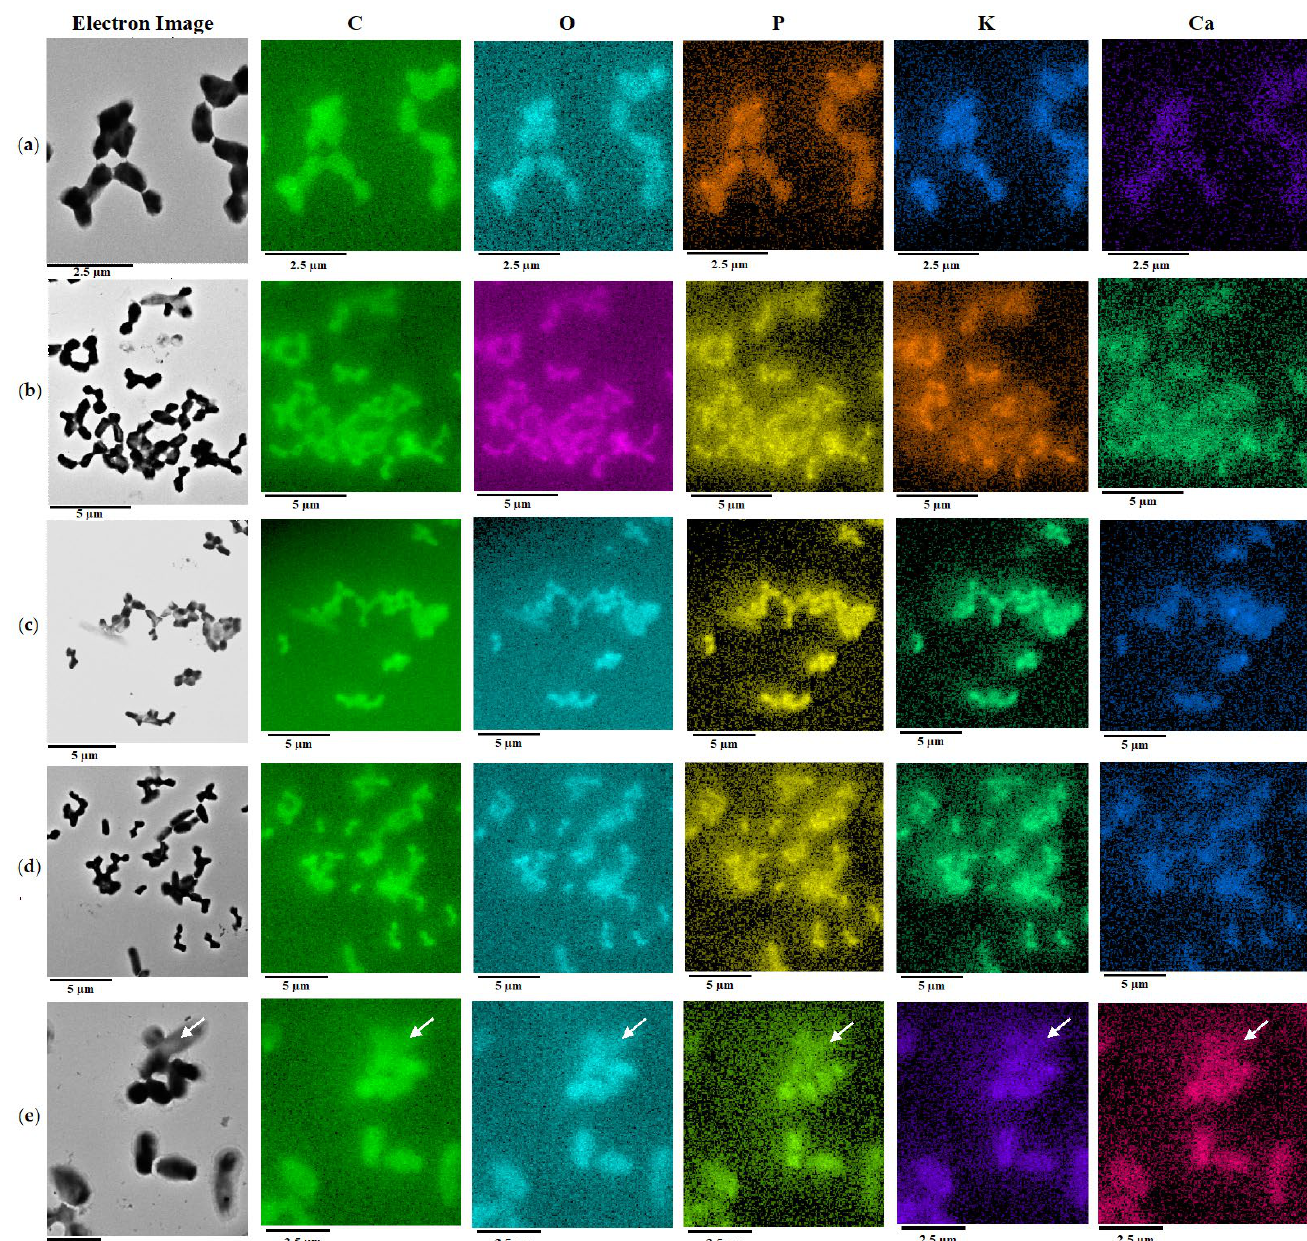
Figure 4. Elemental composition of R . rhodochrous IEGM 1362 determined by mapping using X-ray microanalysis. Distribution of individual chemical elements is highlighted with color. Cell growth on: ( a )–BTN agar, ( b )– BTN agar plus (‒) -isopulegol, ( c )–BTN agar plus HNT, ( d )– BTN agar plus (‒